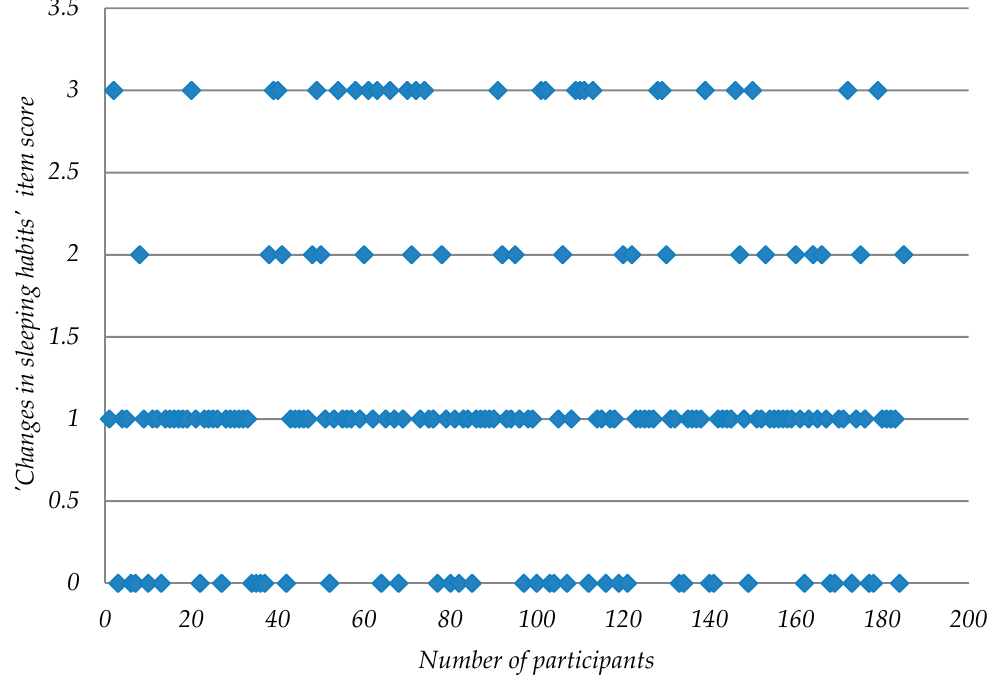
Figure 8. Dispersion plot of BDI-II Item “Changes in sleep habits”.